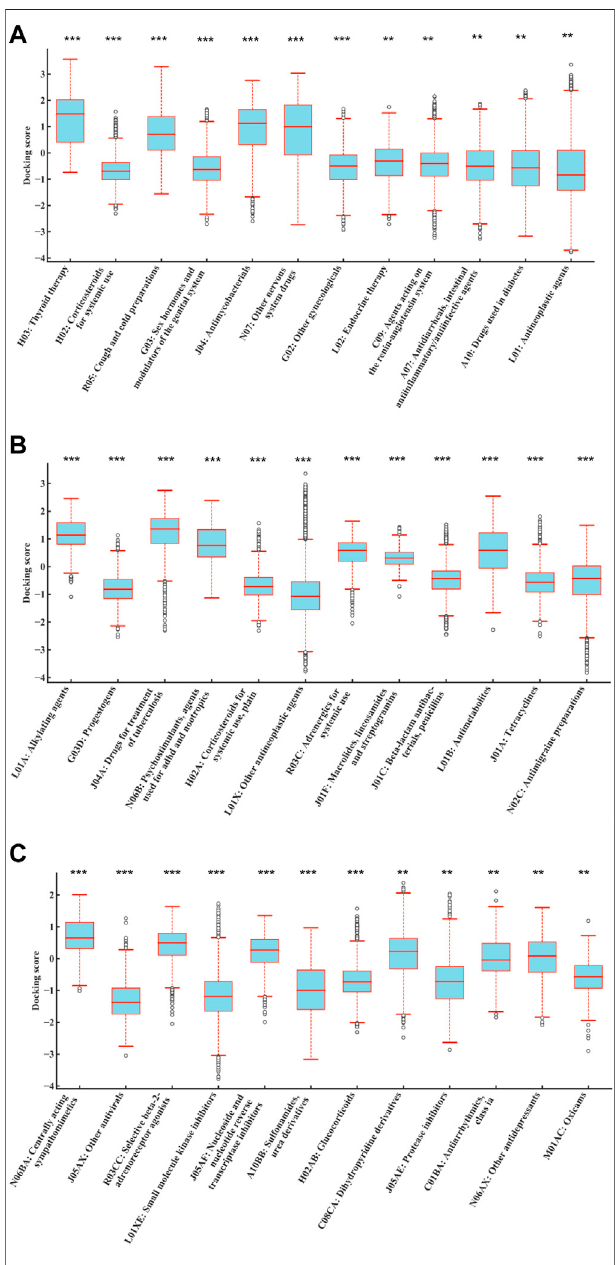
FIGURE4| Distributionsofnormalized averagedockingscoresofdrugs categorized by different levels of ATC codes. The y -axis indicates the normalizedaveragedockingscores.The x -axisrepresentsdifferentATCcode categories. (A – C) represent ATC code levels from second to fourth. Drugs with ATC codes L01, L01X, and L01XE were all signi fi cantly different against other groups ( p = 6.74E-03, 2.25E-08, and 4.19E-11, respectively) (ANOVA). It indicated that the result scores of KIs (ATC code: L01XE) were signi fi cantly better (lower in scores) than those of other types, which indicates that KIs may bind to mitochondrial proteins and cause DILI. #The results were sorted by signi fi cance from high to low, and only the fi rst 12 were shown. *** p < 0.001; ** p < 0.01; * p <